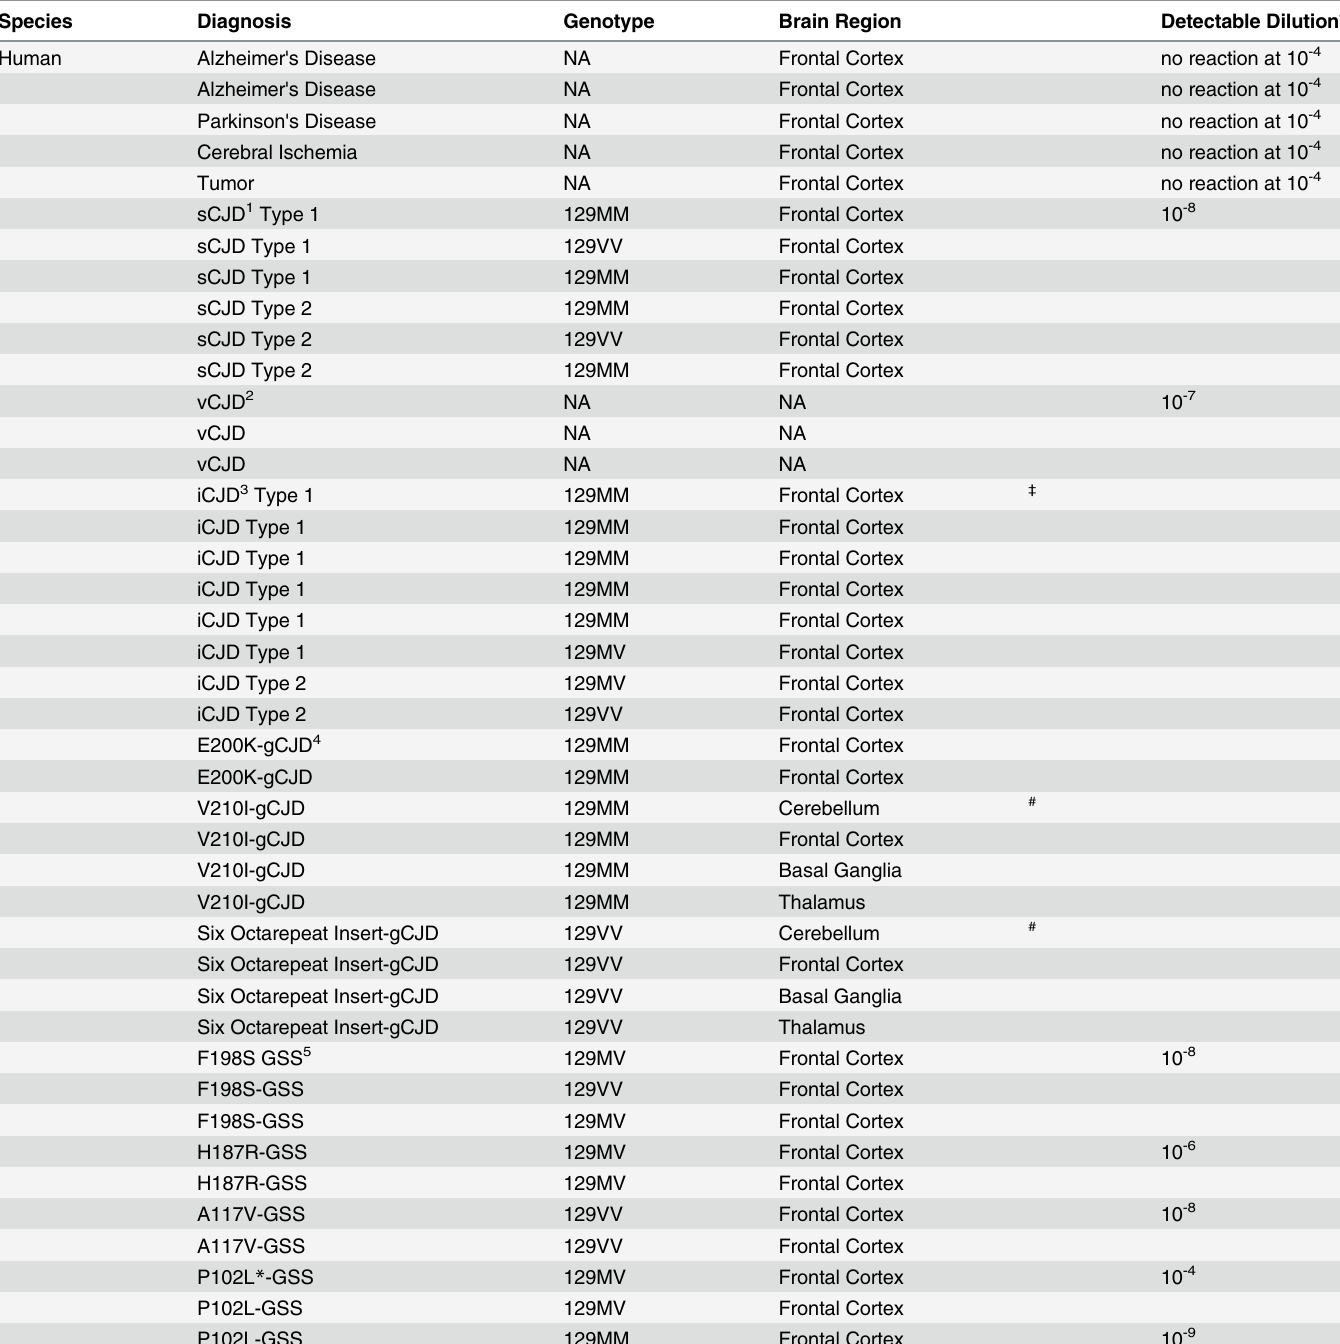
Table 1. Human samples: diagnosis, PRNP genotype and brain